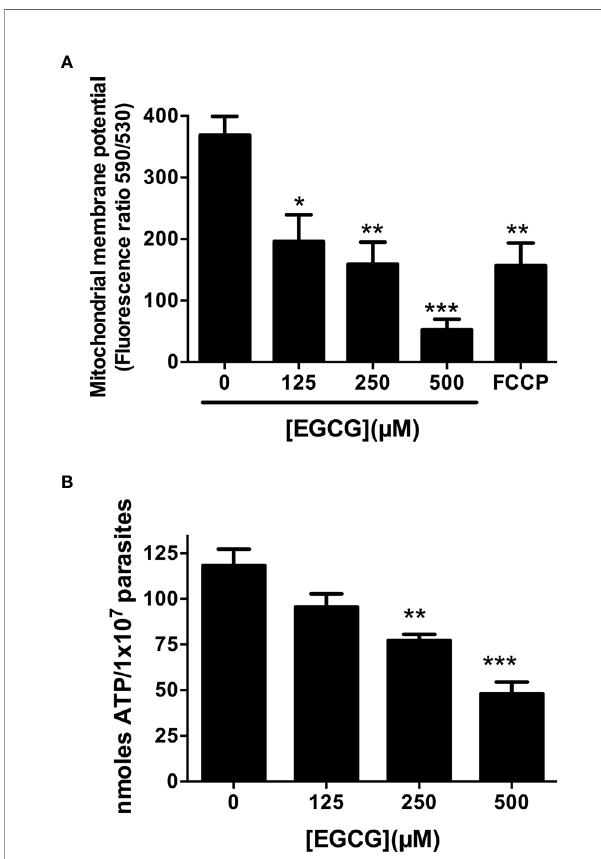
FIGURE 2 | EGCG induces mitochondrial depolarization in L. infantum with concomitant loss of intracellular ATP. Leishmania infantum promastigotes were cultivated in Schneider ’ s Drosophila medium at 26°C for 72 h in the absence or presence of 125 – 500 µM EGCG. Promastigotes were stained with the potentiometric probe JC-1 (10 µg/ml). The positive control was treated with FCCP (20 µM) for 20 minutes. In the control (absence of EGCG), the same volume of vehicle (PBS) was added to the growth medium. Concentration- dependent alterations in relative mitochondrial membrane potential ( DY m ) values are expressed as the ratio of the fl uorescence measurements at 590 nm (for J-aggregate) versus 530 nm (for J-monomer) (A) . Promastigotes were incubated with EGCG (125 - 500 µM) for 72 h. Intracellular ATP concentrations were measured using a bioluminescence assay. The results are expressed as ATP concentration (B) . Data represent means ± standard errors of three different experiments run in triplicate. * indicates a signi fi cant difference relative to the control group (p < 0.05); ** indicates a signi fi cant difference relative to the control group (p < 0.01); *** indicates a signi fi cant difference relative to the control group (p < 0.001).